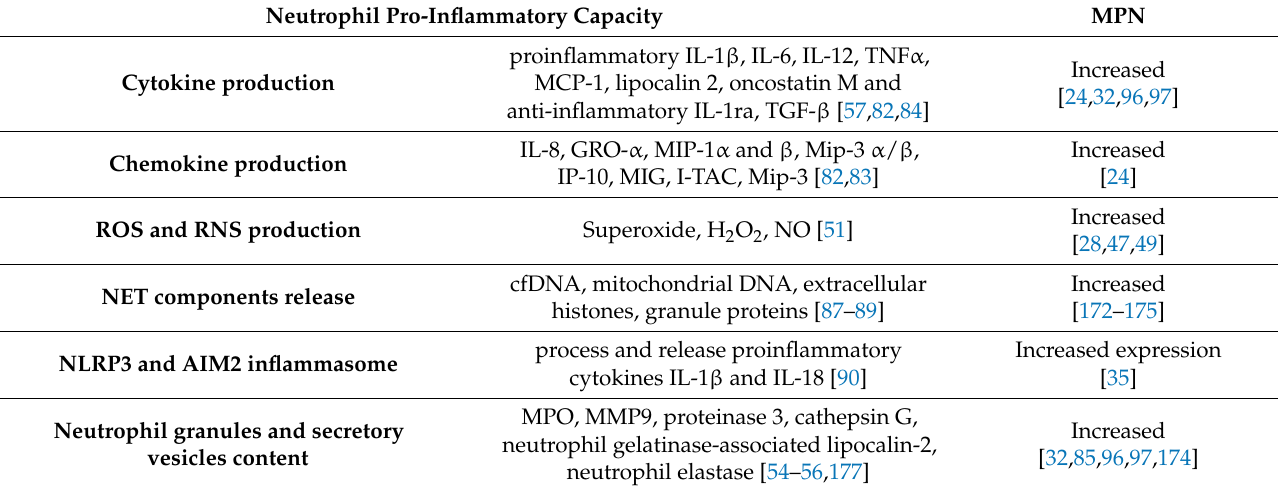
Figure 2. Putative role of dysregulated neutrophil cell death in MPN. Neutrophil prolonged survival and activity, due to its dysregulated apoptosis, supports inflammation and regulates eventual out- come of a disease (sustained genetic instability, positive selection of neoplastic clone, consequent dissease progression). MPN: myeloproliferative neoplasms; JAK: Janus kinase 2; STAT: signal trans- ducers and activators of transcription; PI3K: phosphatydilinositol-3-kinase; AKT: RAC-alpha/beta serine/threonine-protein kinase/protein kinase B; MAPK: mitogen activated protein kinase; ERK: extracellular signal-regulated kinase. Table 3. Neutrophil pro-inflammatory capacity in